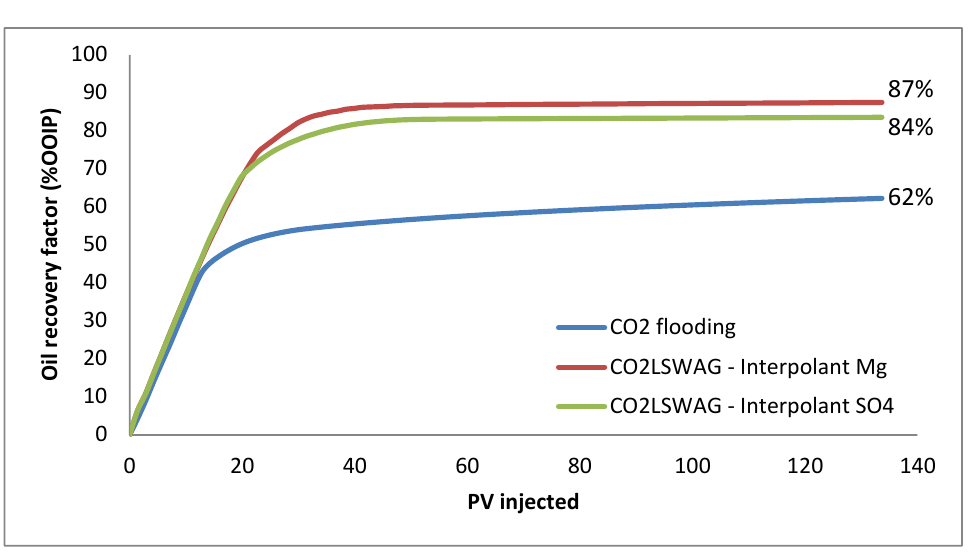
Figure 3. Oil recovery factor for continuous CO 2 injection and CO 2 -LSWAG considering Mg and SO 4 as ion interpolant.